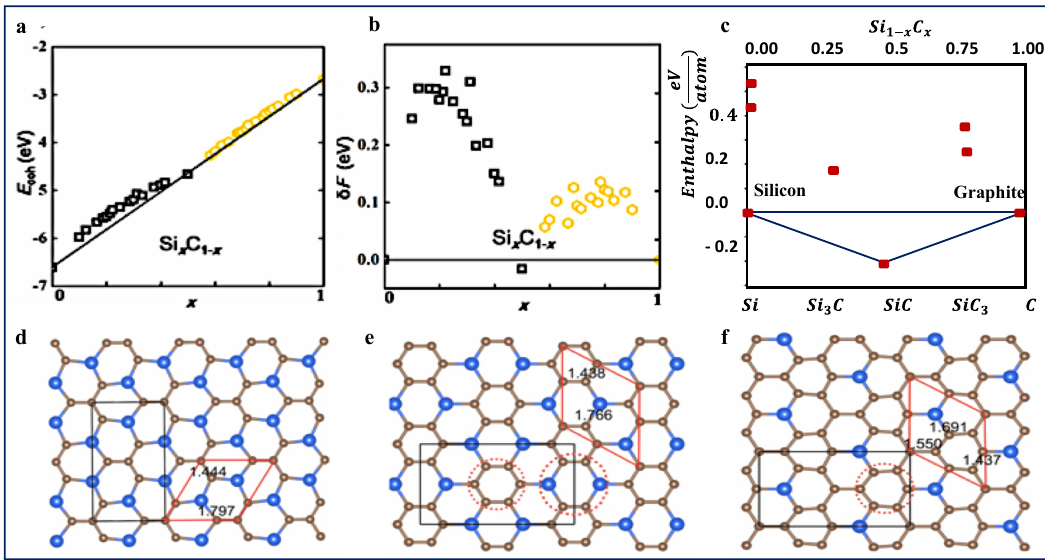
Figure 2. Cohesive energies, formation energies, and structures of SixCy materials. ( a , b ) Predicted cohesive energies and formation energies of 2D SixCy. Reprinted with permission from [9]. Copyright (2015) American Chemical Society. ( c ) predicated formation enthalpies of bulk Si x C 1 − x . Reprinted with permission from [36]. Copyright (2013) American Chemical Society. As shown in ( a ), all investigated Si x C y structures have negative cohesive energy, meaning that they are energetically favorable. These values also suggest that if these structures can be made, they will resist and will not break into graphene, or any other materials. However, as shown in b and c, only Si 0.5 C 0.5 has a negative formation energy, an indication of high stability. ( d – f ) predicted structures for SiC 2 ,SiC 3 ,and SiC 7 respectively. Republished from [49], with permission from IOP. As shown, unlike 2D SiC which has average bond length of 1.79 Å, two bond lengths exist in the presented structure, one belongs to C-C, and the other to Si-C. It should also be noted that more than a hundred structures have been predicted for 2D Si (cid:3051) C (cid:3052) , and the presented structures here only represent a few examples of the most studied structures.